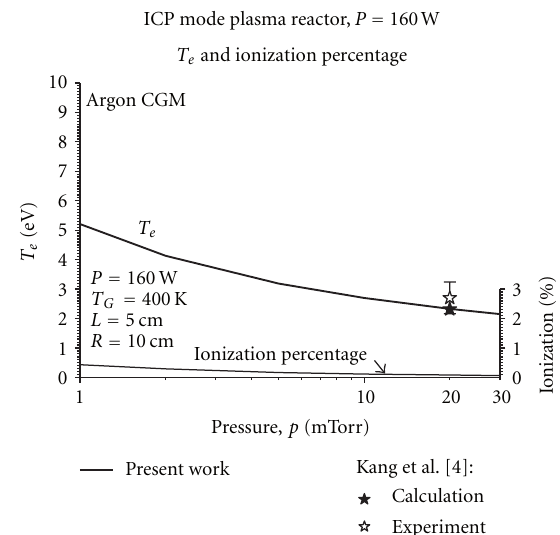
Figure 5: Calculated T e and ionization percentage in the plasma